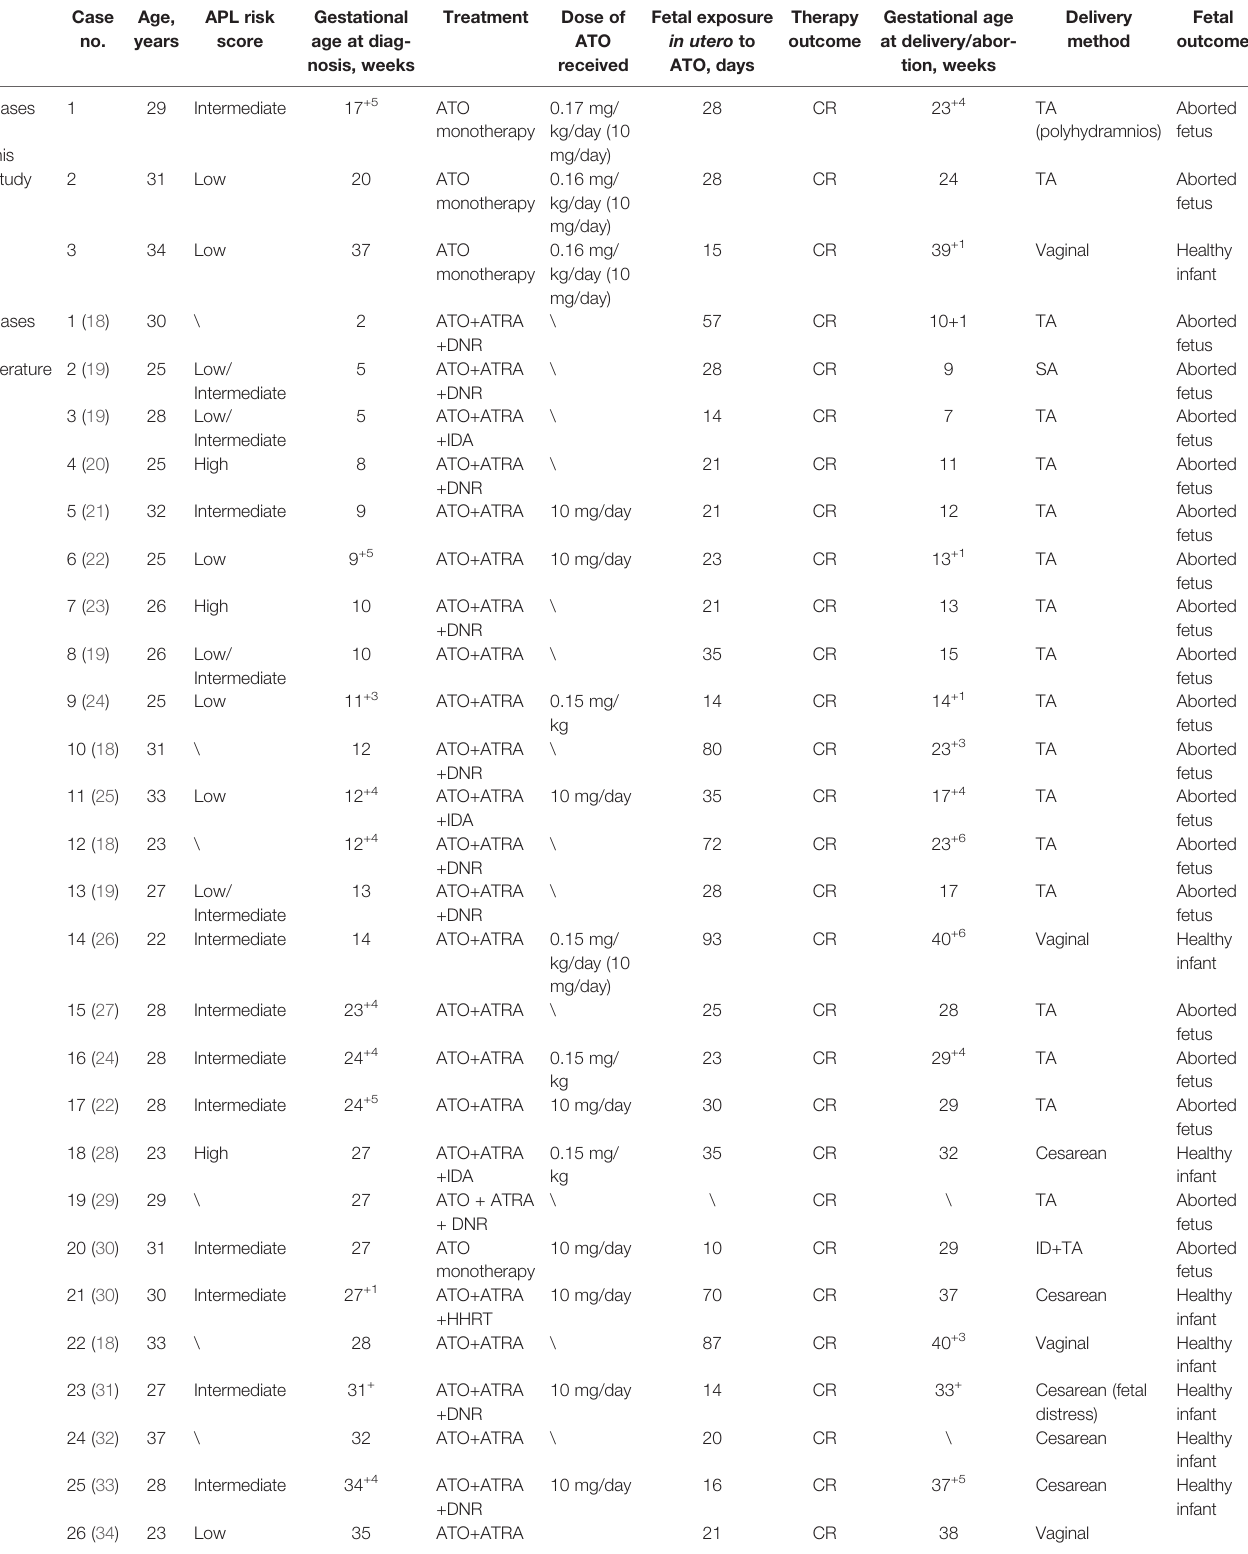
TABLE 4 | Clinical characteristics and maternal and fetal outcomes in pregnant women with APL treated with ATO in this study and literature. Case